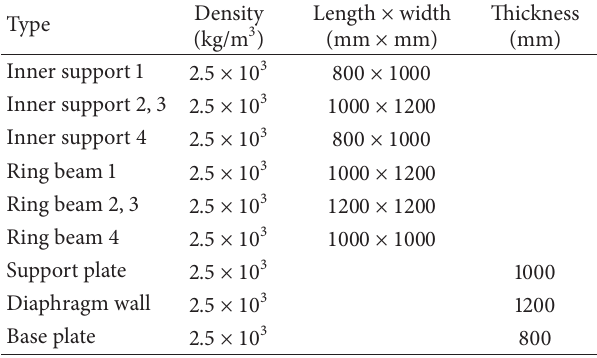
Table 2: Parameters of the supporting structure.